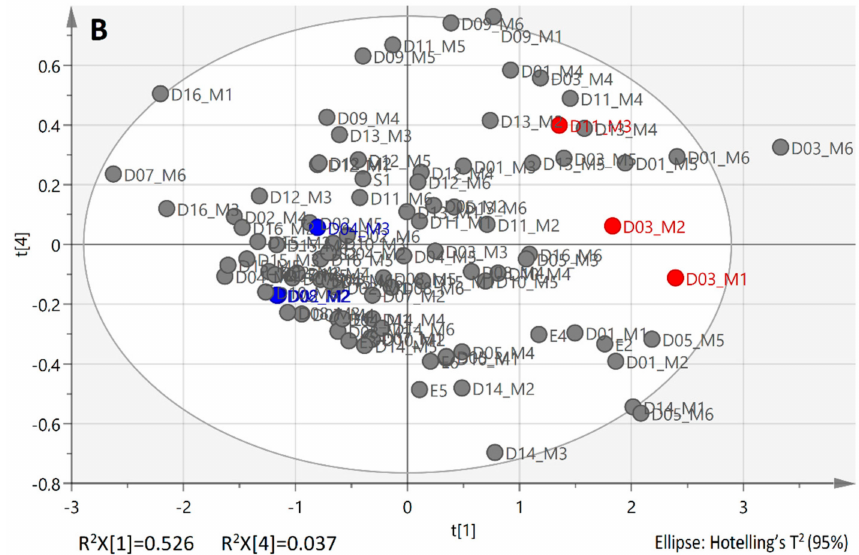
Figure 4. GC-MS chromatographic profiles of randomly selected EOs originated from three female and three male bay laurel leaves ( A ); projection of the same EO samples on the PC14 scoreplot of